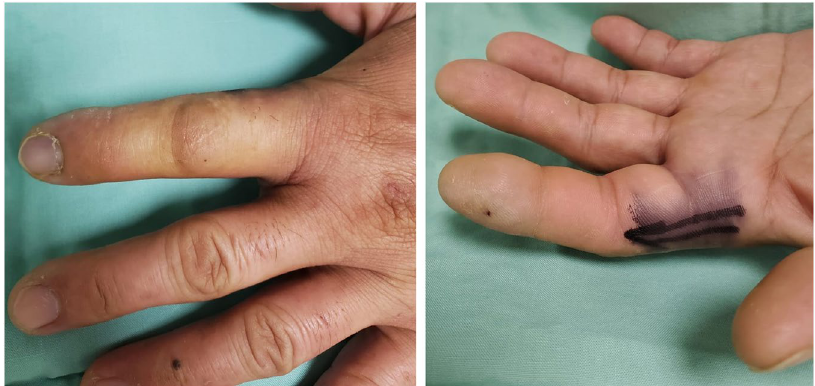
Figure 1. ( a , b ) Index injection injury with collection prior to drainage following automatic syringe injector